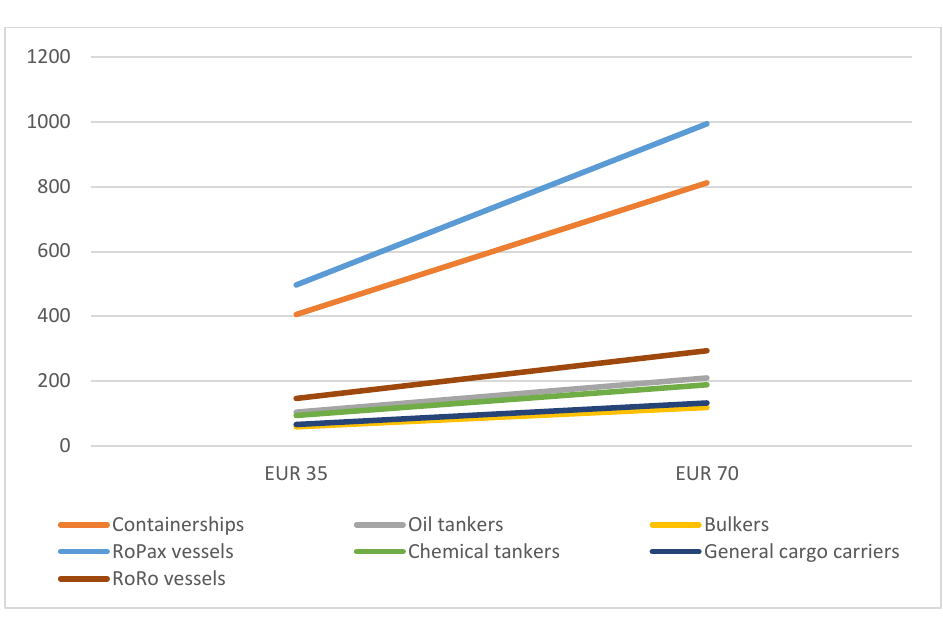
Figure 5. Cost increase per maritime segment assuming the inclusion of only internal EU voyages, expressed in MEUR. Source : Created by the authors